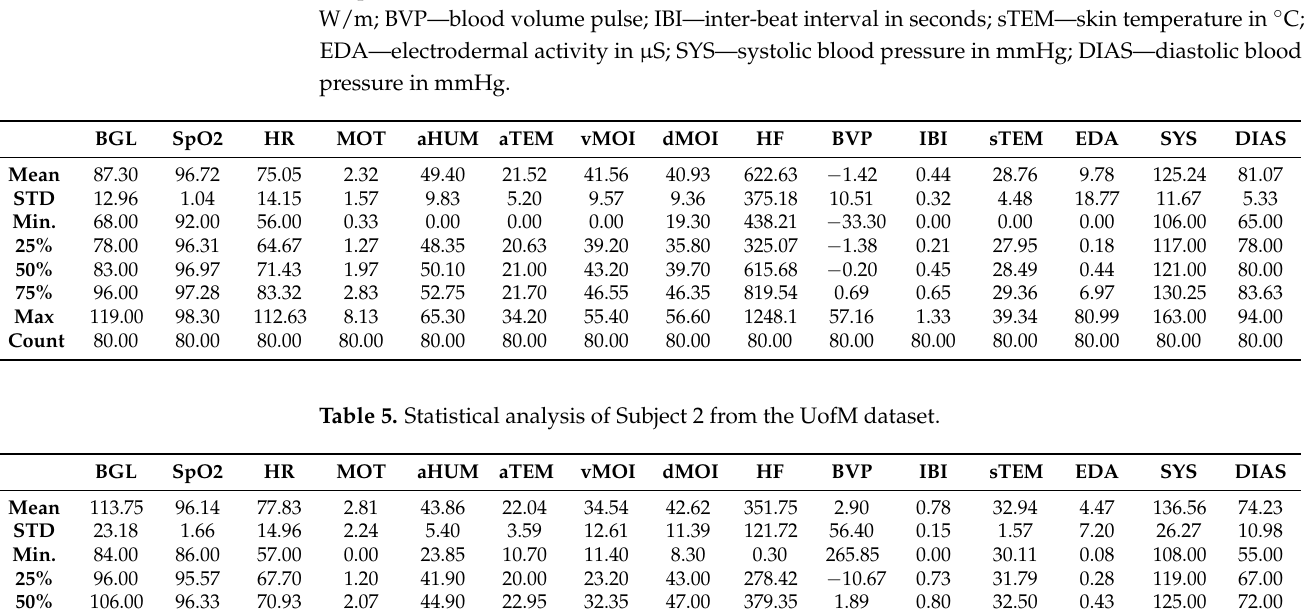
Table 4. Statistical analysis of Subject 1 from the UofM dataset: BGL—blood glucose level in mg/dL;